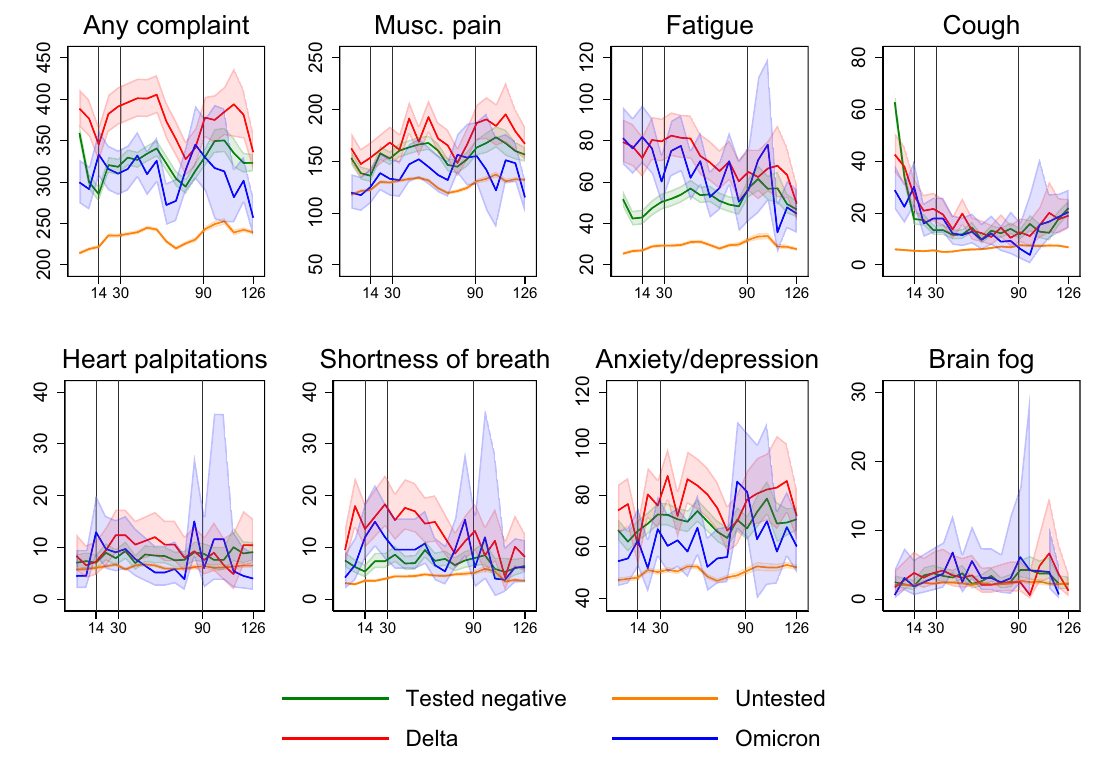
Fig. 4 | Weekly proportions having post-covid complaints per 10 000 indivi- dualsintheacute(14 – 29days),sub-acute(30 – 89 days)andchronic( ≥ 90days) post-covid phases, as distinguished by vertical lines for days 14, 30 and 90. Data are presented as the number of individuals visiting primary care for the out- come in question at least once a week per 10,000 individuals in each group